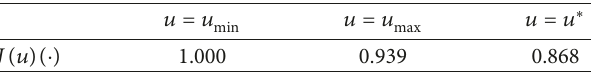
Table 5: The values of the objective function in the passive and the switched control cases.